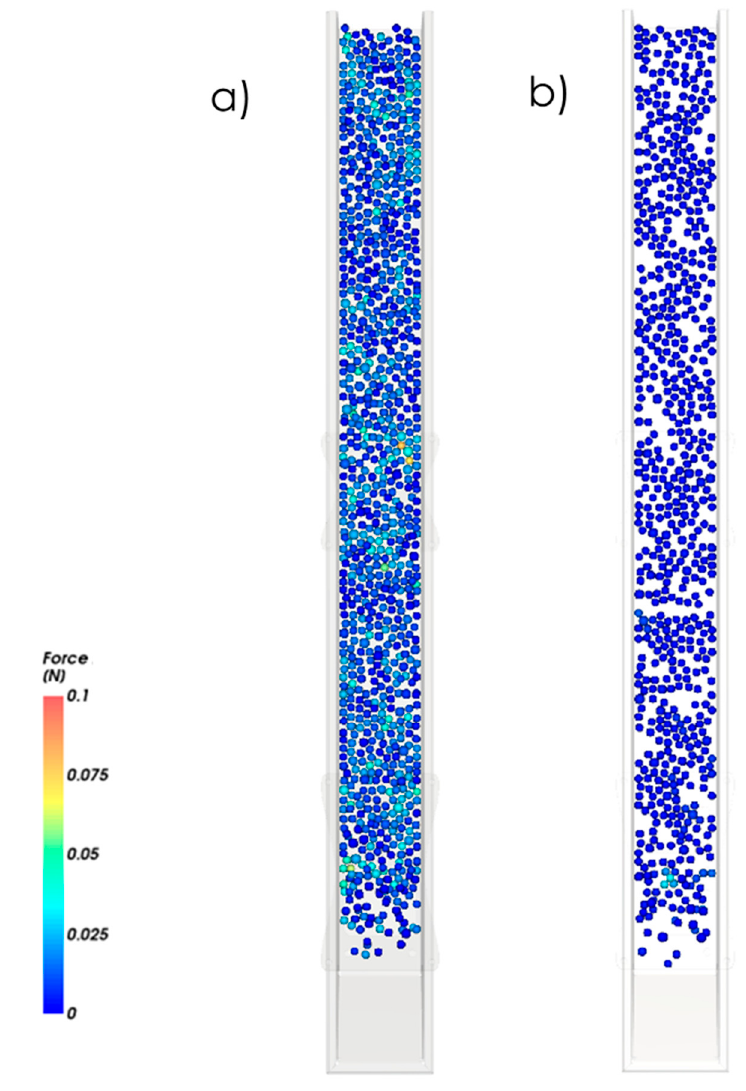
Figure 15. The comparison of tangential forces on blueberry fruit during transport on the reciprocating chute ( a ) and on the vibrating chute ( b ).